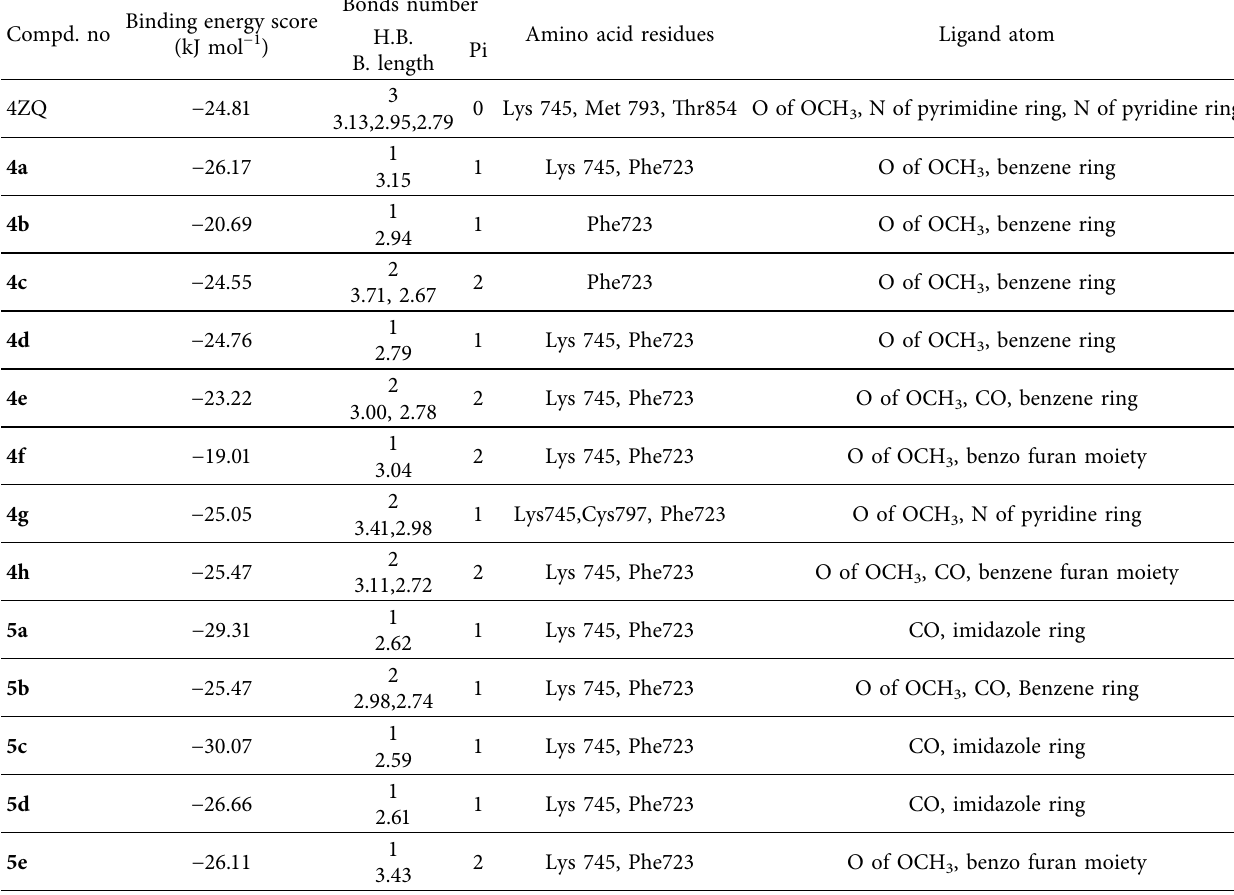
Table 2: Docking results of the newly synthesized compounds 4a–h , 5a-h , and 7a , b docked with EGFR protein (PDB ID: 5CAV) active site. Binding energy score Compd. no (kJ mol − 1